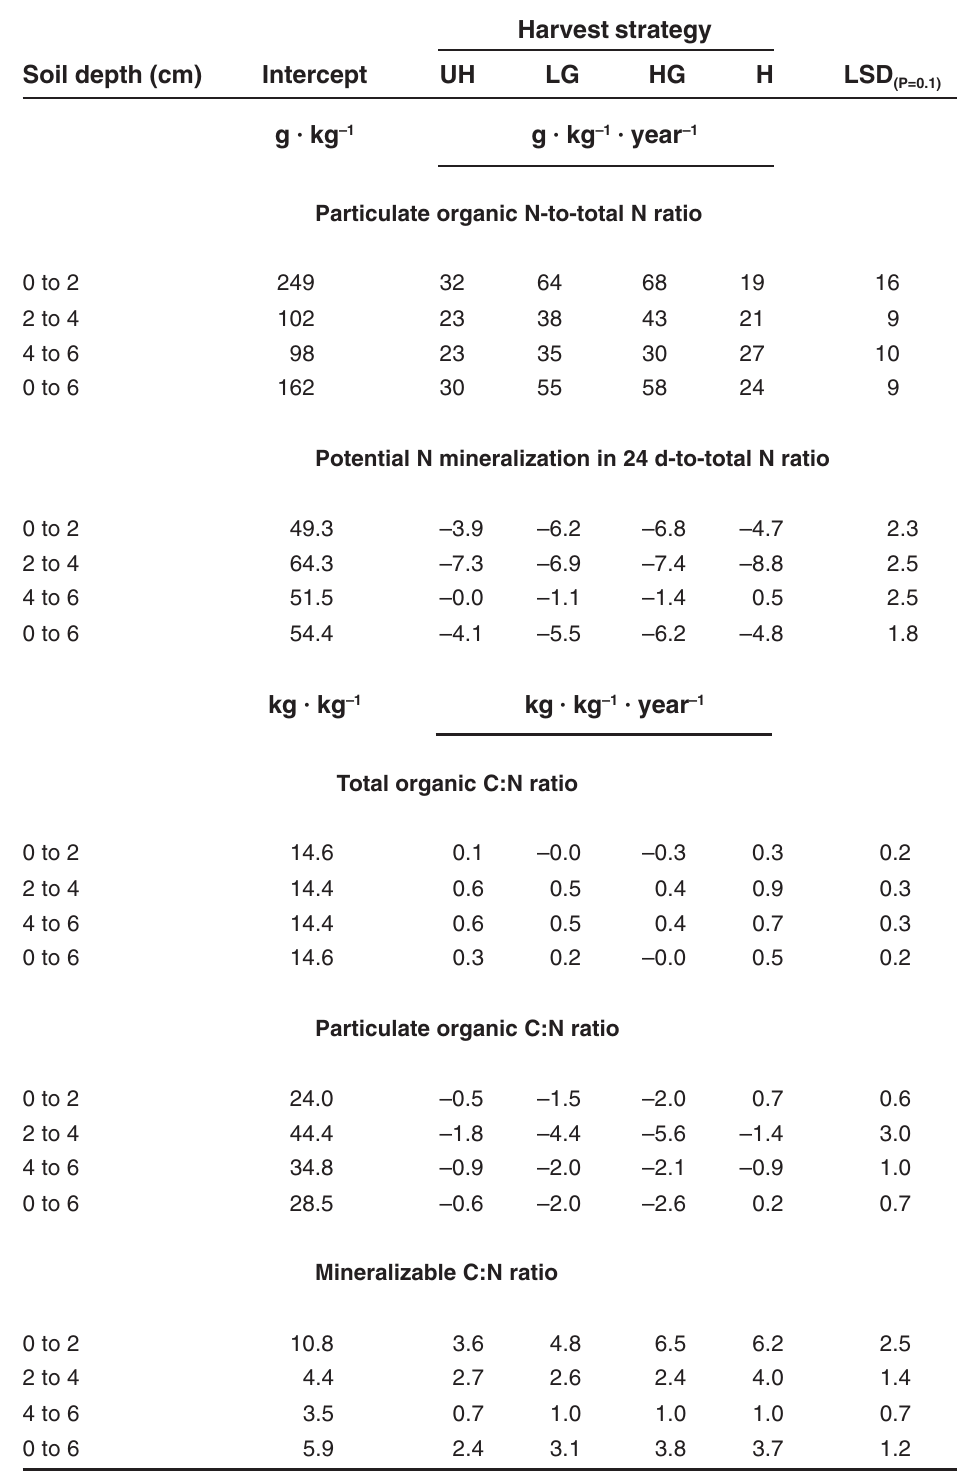
Rate of Change in Ratios of Soil N and C Pools, Based on Linear Regression, During the First 4 Years of Management as a Function of Soil Depth and in Response to Harvest Strategy Averaged across Fertilization